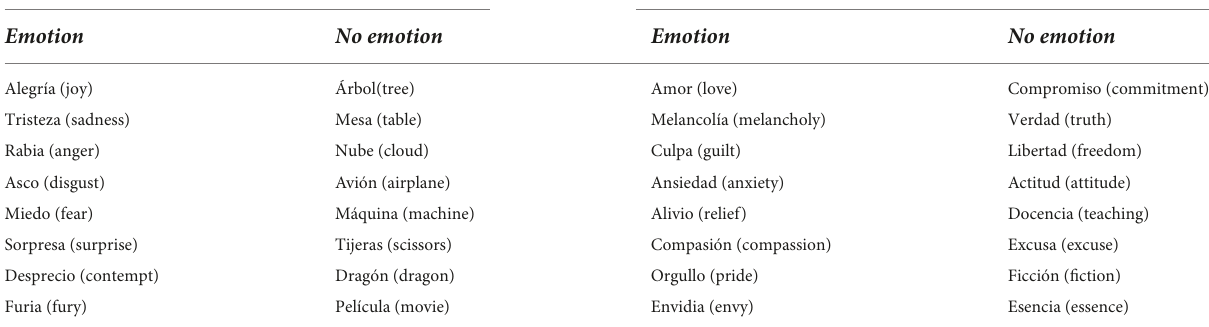
TABLE 1 Selected concepts in the present